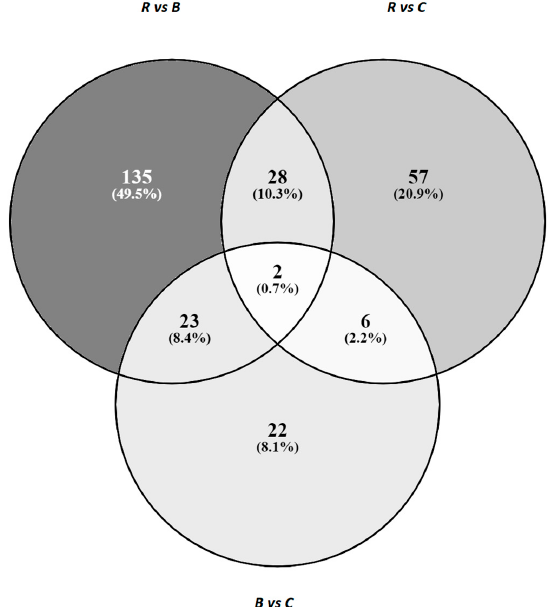
Figure 2. Venn diagram illustrating differentially expressed genes that are common between comparisons.